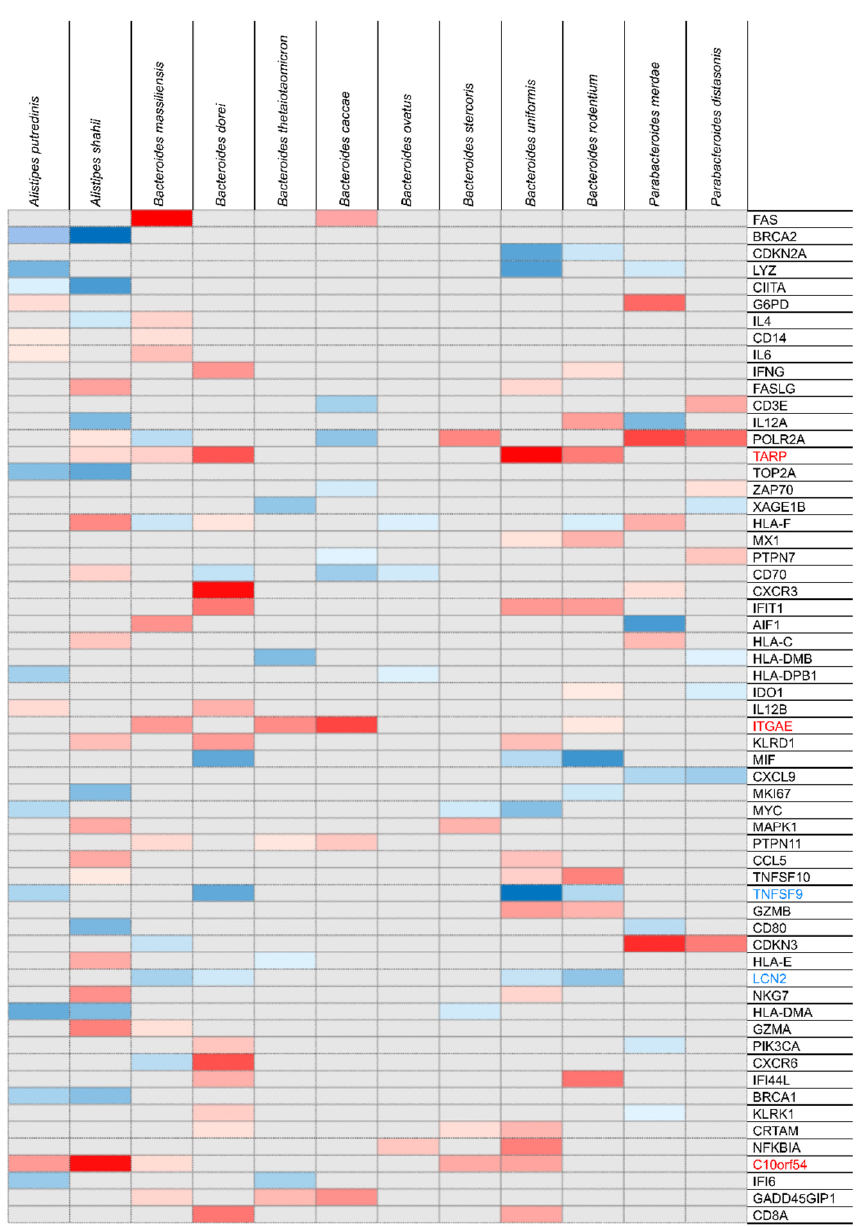
Figure 2. Heatmap of the correlation between 12 key Bacteroidetes species components and expression levels of ulcerative colitis-related genes in the colonic mucosa. The gray scale of the heatmap indicates no significant correlation at p > 0.05, while the red and blue scales indicate positive and negative correlations, respectively. The greater the correlation, the darker the color. TARP and C10ORF54 (also known as VISTA ) expression showed a significant positive correlation with five Bacteroidetes species, while that of integrin α E gene ( ITGAE or CD103 ) was also significantly positively correlated with four Bacteroidetes species. Meanwhile, TNFSF9 (also known as CD137 or 4-1BB ) and lipocalin 2 ( LCN2 ) expression was significantly negatively correlated with four Bacteroidetes species.